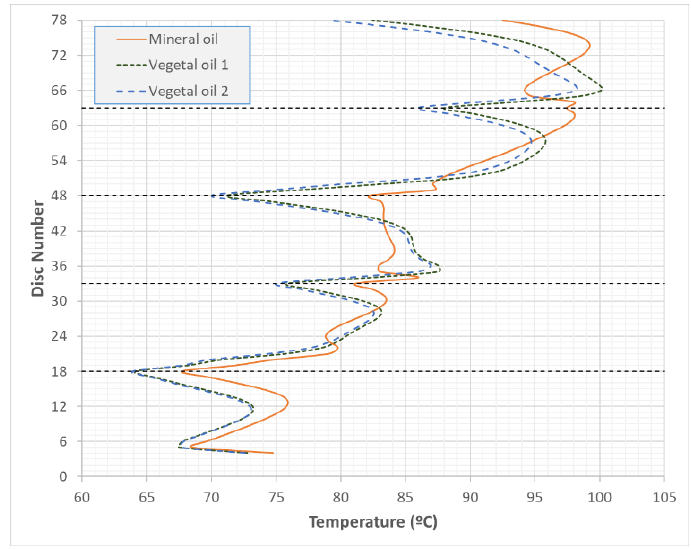
Figure 3. Average temperature of discs with 5 pass geometry [30]. The complete study is reported in [30]. Reprint with permission [30], Copyright 2019, IEEE.